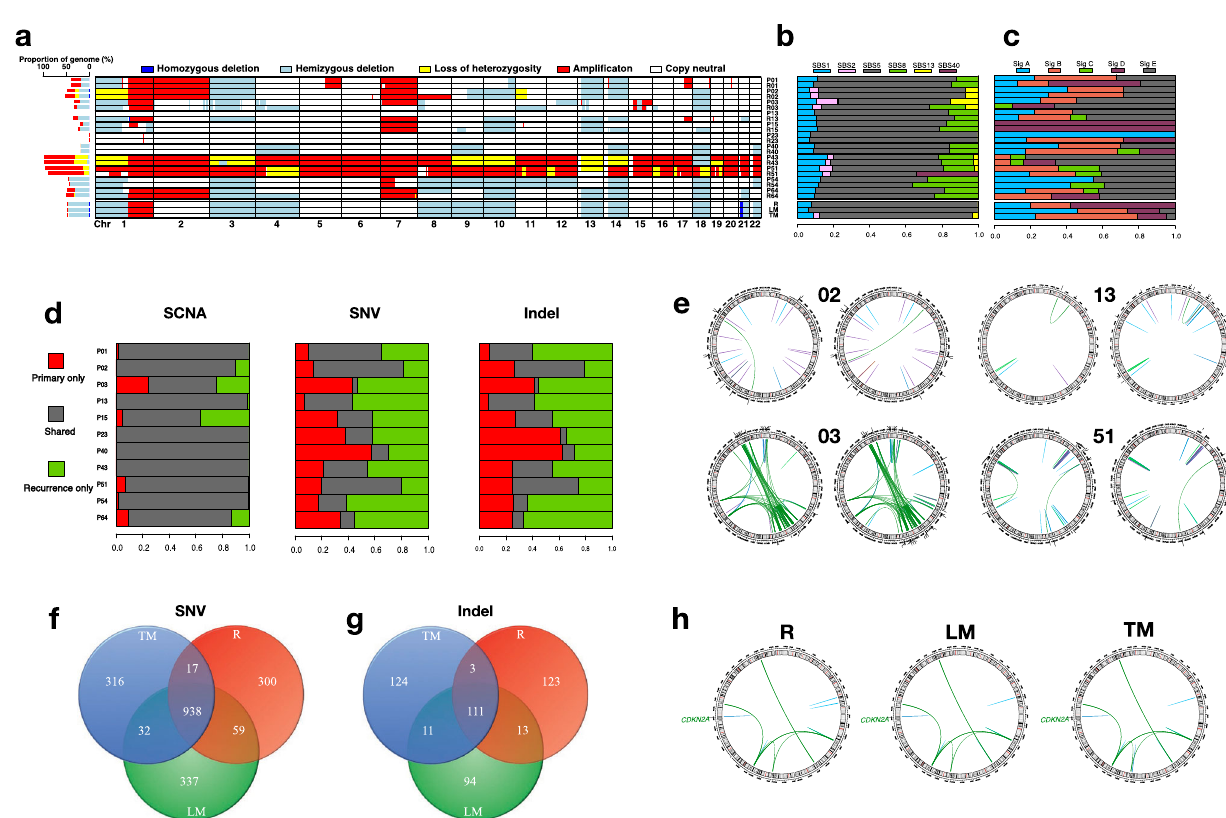
Fig. 6 Comparison of genomic alterations between paired primary tumor and recurrence/metastasis samples. Comparison of somatic copy number alterations (SCNAs, panel ( a )), COSMIC single-base substitution (SBS) signatures (panel ( b )), and de novo indel signatures (panel ( c )) in 11 paired primary tumor (P) and recurrence (R) samples (upper) as well as three paired tumor and metastasis samples (lower). R recurrence, LM lymph node metastasis, TM thoracic metastasis. d Shared proportion of SCNAs, single nucleotide variations (SNVs), and indels in 11 paired primary tumor and recurrence samples. Each bar indicates the proportion of alterations in primary tumor only (red), recurrence only (green), and shared between primary and recurrence samples (gray) within each patient. e Comparison of structural variants (SVs) in four paired primary tumor and recurrence samples with total number of SVs larger than 20. Number of SNVs ( f ) and indels ( g ) shared among R, LM, and TM samples. h Comparison of SVs among R, LM, and TM samples. See also Supplementary Fig.